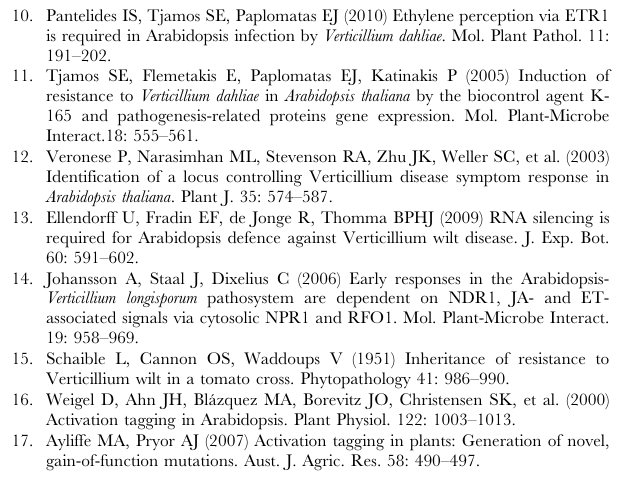
File S1 Figure S1. Expression analysis of genes flanking the insertion site in the A2 mutant when compared to wild-type (WS) plants in absence of pathogen inoculation. The gene encoding EWR1 is boxed ( At3g13437 ). Reactions to amplify the Actin 2 gene and a non-template control (NTC) were included as controls. Figure S2. Relative quantification (RQ) of EWR1 transcription. (A) Relative quantification (RQ) of EWR1 transcription in wild-type (WS) and activation-tagged mutants (A1–A4). Bars represent averages with standard deviation of three biological replicates. (B) Relative quantification (RQ) of EWR1 transcription in wild-type (Col-0) plants, two independent EWR1 over-expressing plants ( EWR1-1 and EWR1-2 ), the A2 mutant, and of the EWR1 knock- out line ( ewr1 ). Bars represent averages with standard deviation of three biological replicates. Figure S3. EWR1 over-expressing Arabidopsis plants are resistant to V. dahliae . (A) Typical symptoms of V. dahliae on the wild-type (WS) and three independent EWR1 over-expressing lines in WS background (AtEWR1-4, AtEWR1-5, and AtEWR1-6) at 21 days post inoculation (dpi). Representative of three experimental replicates is shown. (B) Disease severity score for the wild-type (WS) and three independent EWR1 over- expressing lines in WS background (AtEWR1-4, AtEWR1-5,